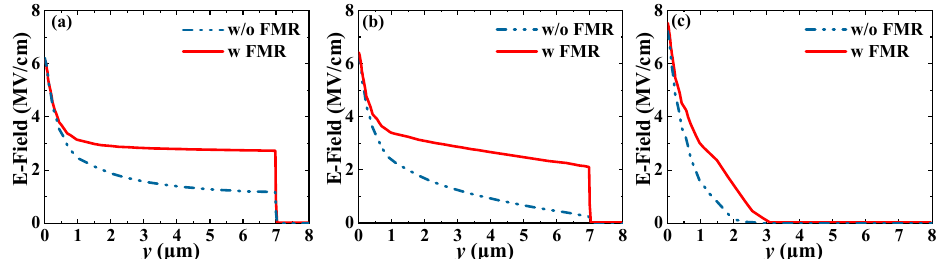
Figure 9. Lateral electric field profile of device with and without FMR, with N epi of ( a ) 10 15 cm − 3 , ( b ) 10 16 cm − 3 , ( c ) 10 17 cm − 3 at the breakdown.